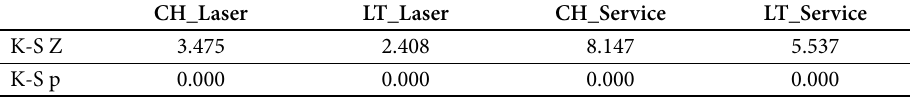
Table 3. Kolmogorov-Smirnov test results for the sample companies